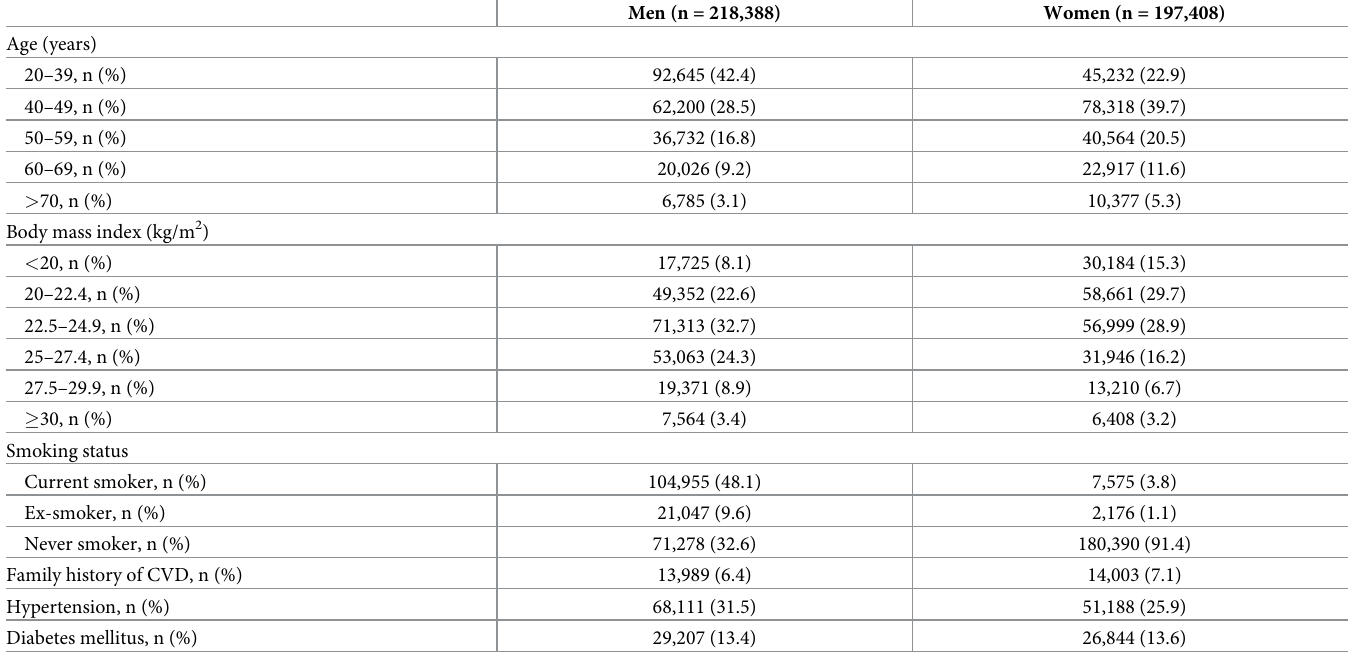
Table 1. Baseline characteristics of the